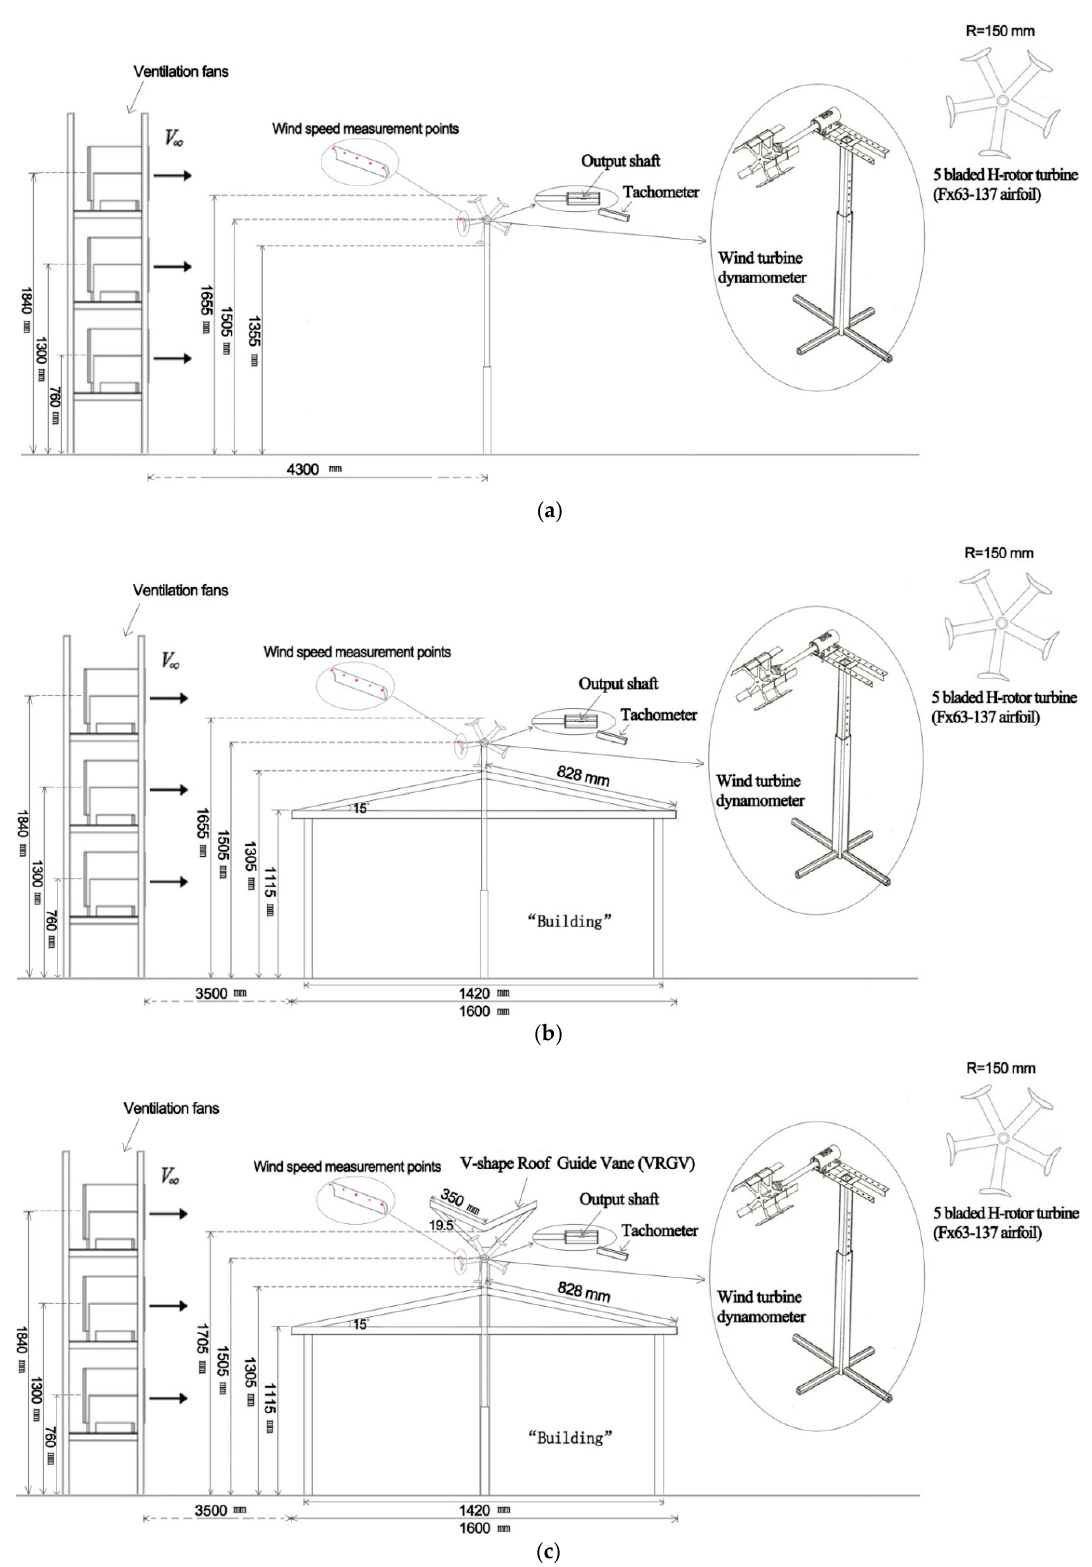
Figure 12. ( a ) Detail dimensions of the experiment set-up for an open rotor VAWT; ( b ) Detail dimensions of the experiment set-up for a VAWT installed on a double slope roof; ( c ) Detail dimensions of the experiment set-up for a VAWT embedded in the double slope roof and VRGV. Since the wind flow wasn’t precisely controlled, the wind speeds were measured at five touch points which were equidistantly distributed on the horizontal direction along one blade of the VAWT (refer to Figure 12). The measurement position was set at 4150 mm downstream of the ventilation fans and the height of 1505 mm (the location of the front edge of the VAWT towards the ventilation fans).